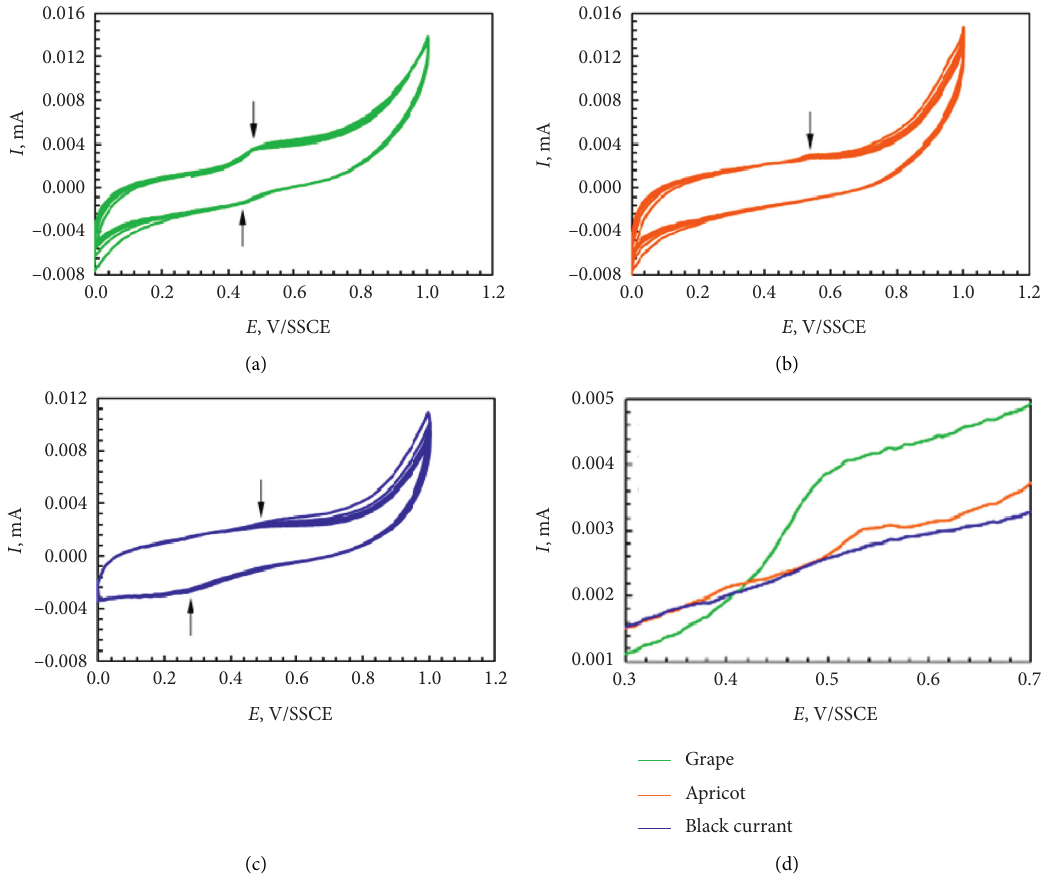
Figure 5: Cyclic voltammograms for the grape (a), apricot (b), and black currant (c) pomace extracts.